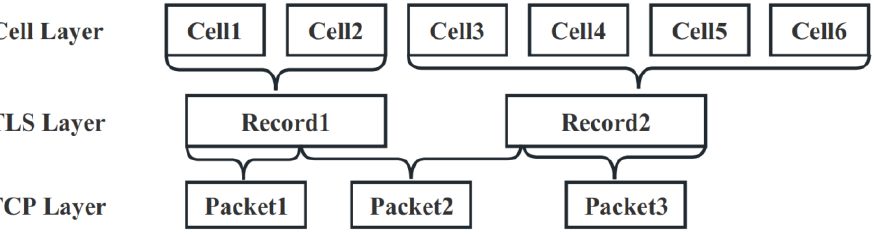
Figure 6. Parallelizing dilated convolutions networks.